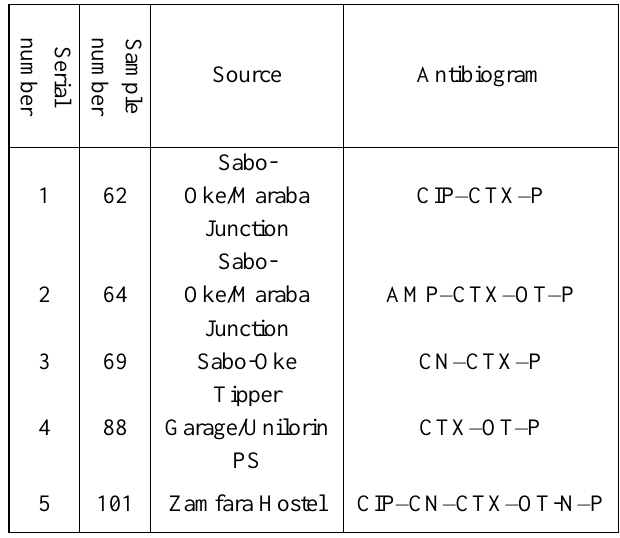
Table 3: Isolated Salmonella spp. from Suya in Ilorin, Kwara state, Nigeria and their antimicrobial resistance phenotypic